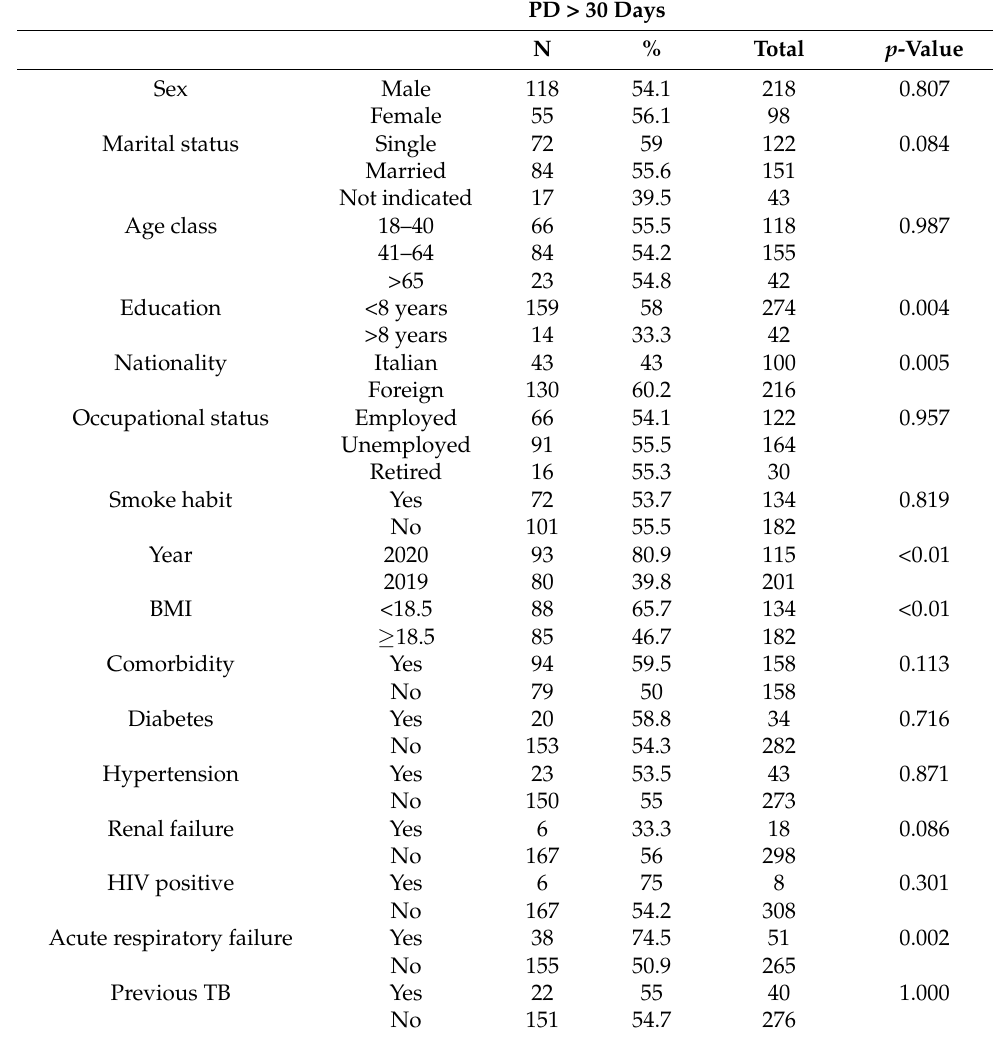
Table 4. Patients with a patient delay (PD) > 30 days, stratified by several patient characteristics.